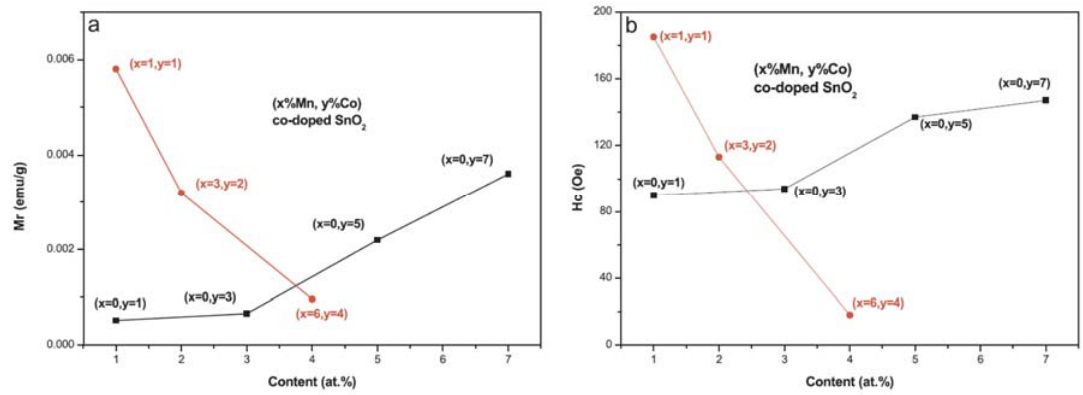
Figure 7. ( a , b ) Magnetization response of M r and coercivity field H c of the prepared Sn 1 ‐ x ‐ y Mn x Co y O 2 , respectively (The Figure was reproduced with copyright permission from reference [57]) .